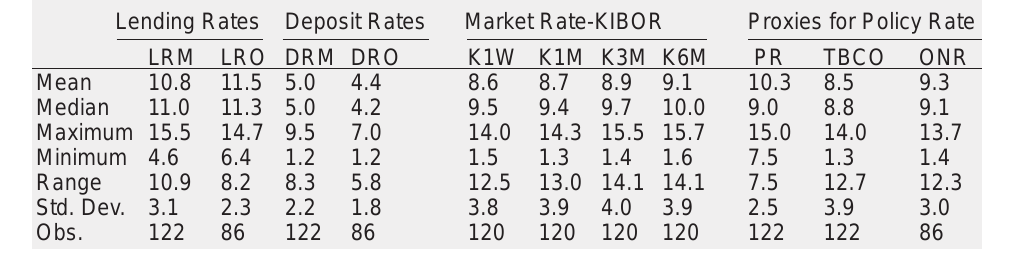
Table 2: Descriptive Statistics of Key Interest